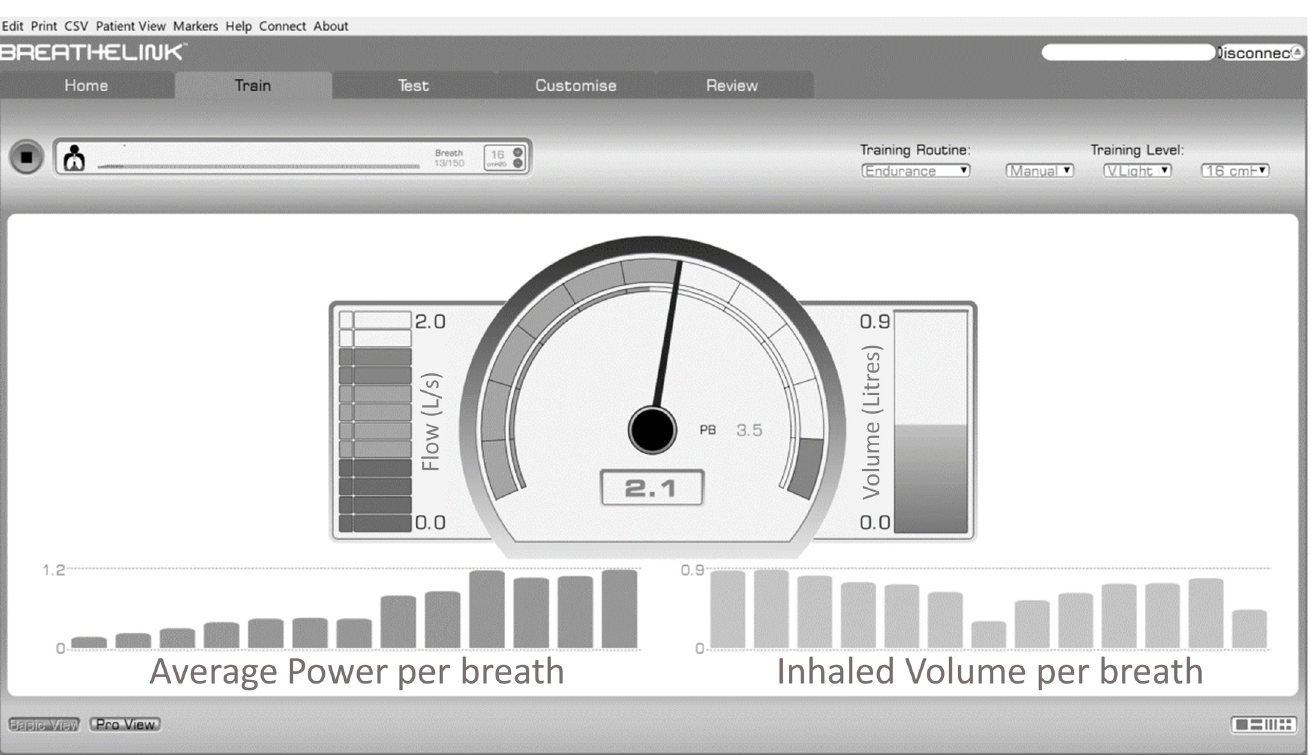
Fig 2. Visual feedback. Real-time visual feedback on breathing characteristics are provided by the Breathe-Link software. In the upper left corner, the amount of inspirations that have been performed against the set inspiratory load is indicated. The general settings of the training are depicted in in upper right corner. In the middle of the screen the pointer indicates the peak power that is performed in the last inspiration. On the left of the pointer the peak flow and on the right of the pointer the inspiratory tidal volume of the last inspiration are shown. In the bars below the mean power and the inspiratory tidal volume of all breaths performed in the session are